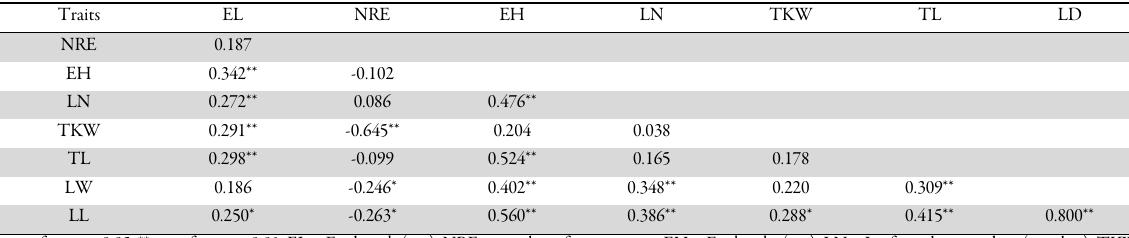
Table 3. Correlation coefficients between agronomic and morphologic traits Traits